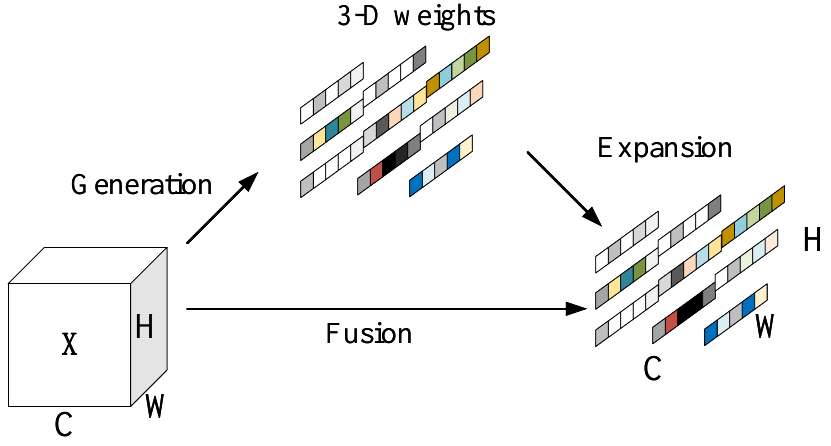
Figure 4. SimAM module structure